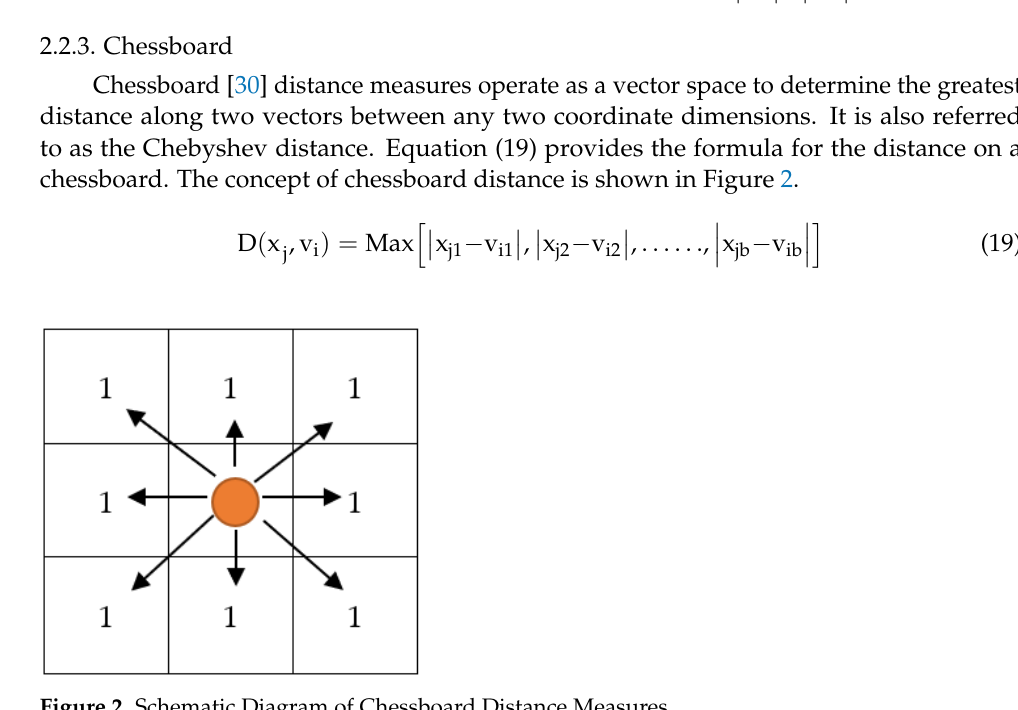
Figure 2. Schematic Diagram of Chessboard Distance Measures.